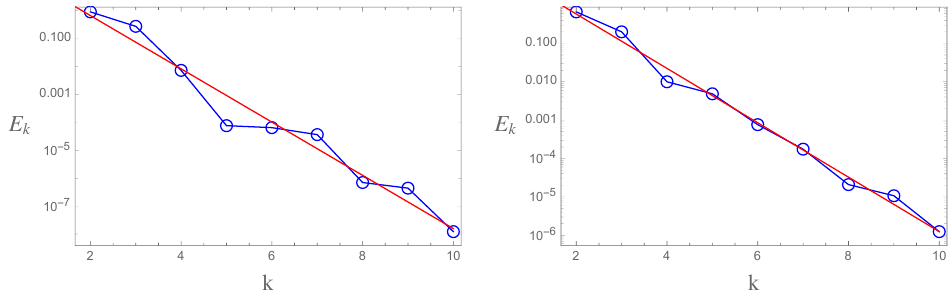
Figure 1 . The error measure E k is simply the value of the functional (2.4) computed for the optimized metric at a given k for the Fermat quartic (left) and quintic (left). We see that the error measure approaches zero